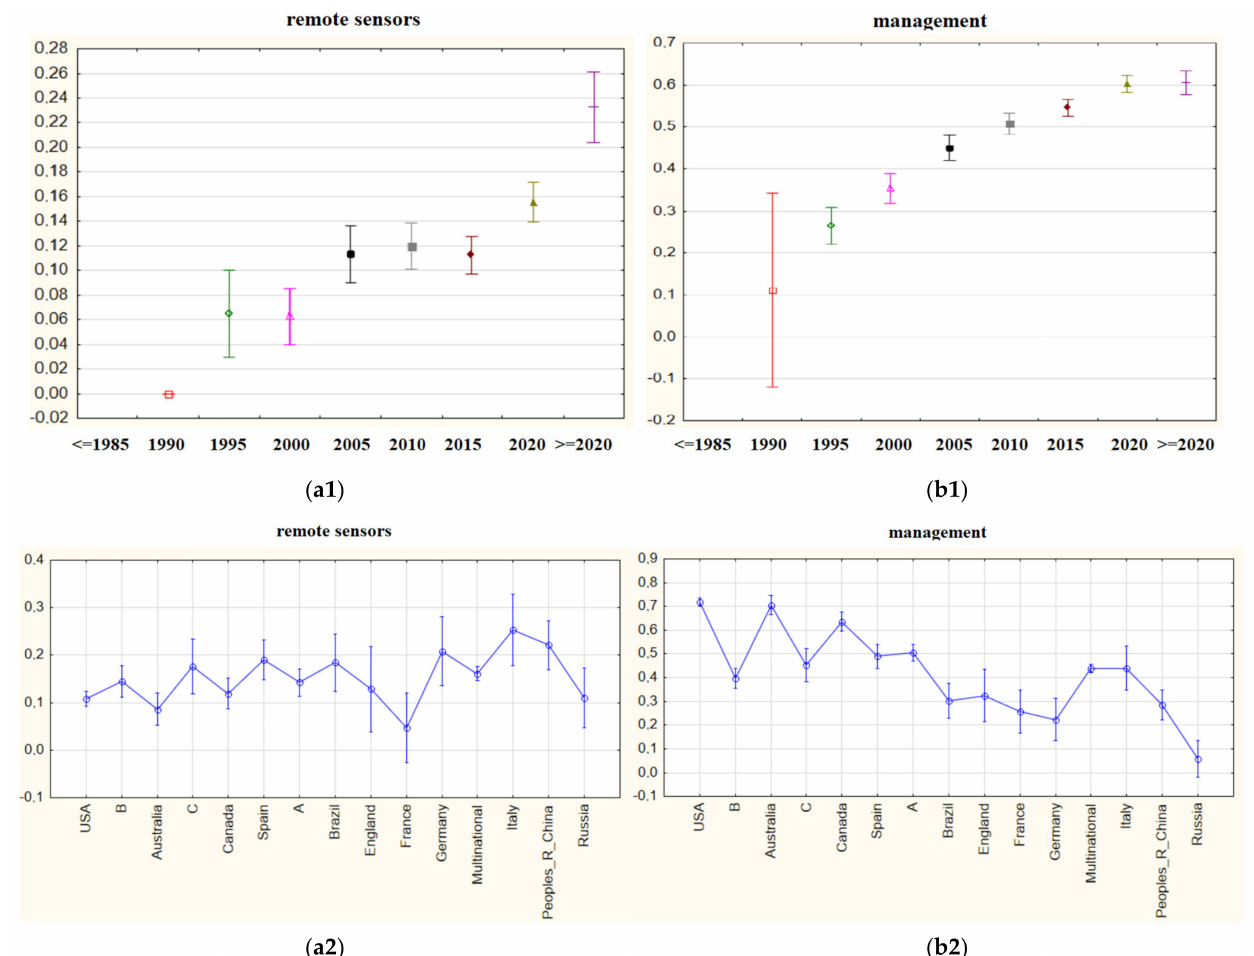
Figure 11. ( a1 ) mean importance weights of the indexed term “remote sensors” for five-year periods; ( b1 ) mean importance weights of the indexed word “management” for five-year periods; ( a2 ) mean importance weights of the indexed term “remote sensors” via countries; ( b2 ) mean importance weights of the indexed word “management” via